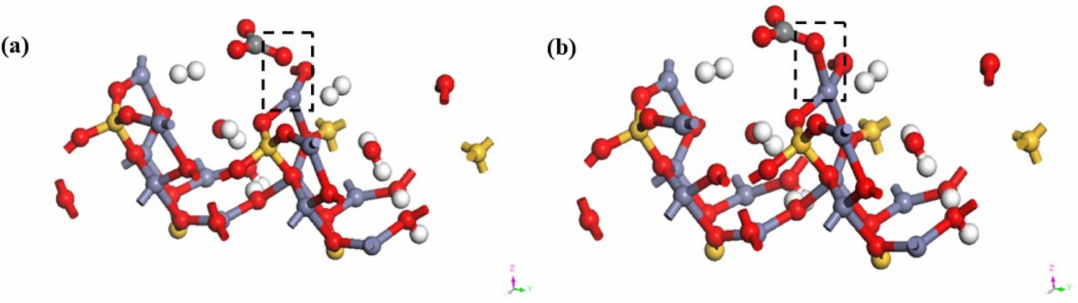
Figure 8. Transformation of initial ( a ) and final ( b ) states of CO 32 − on the surface of the hemimorphite.